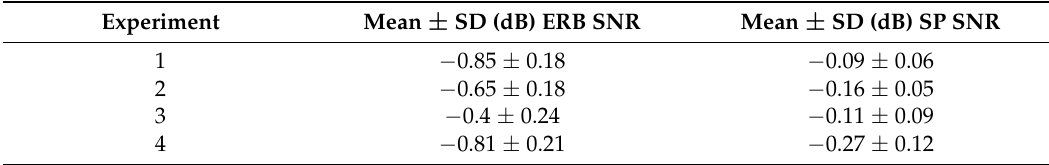
Table 2. SNR Comparison Summary.